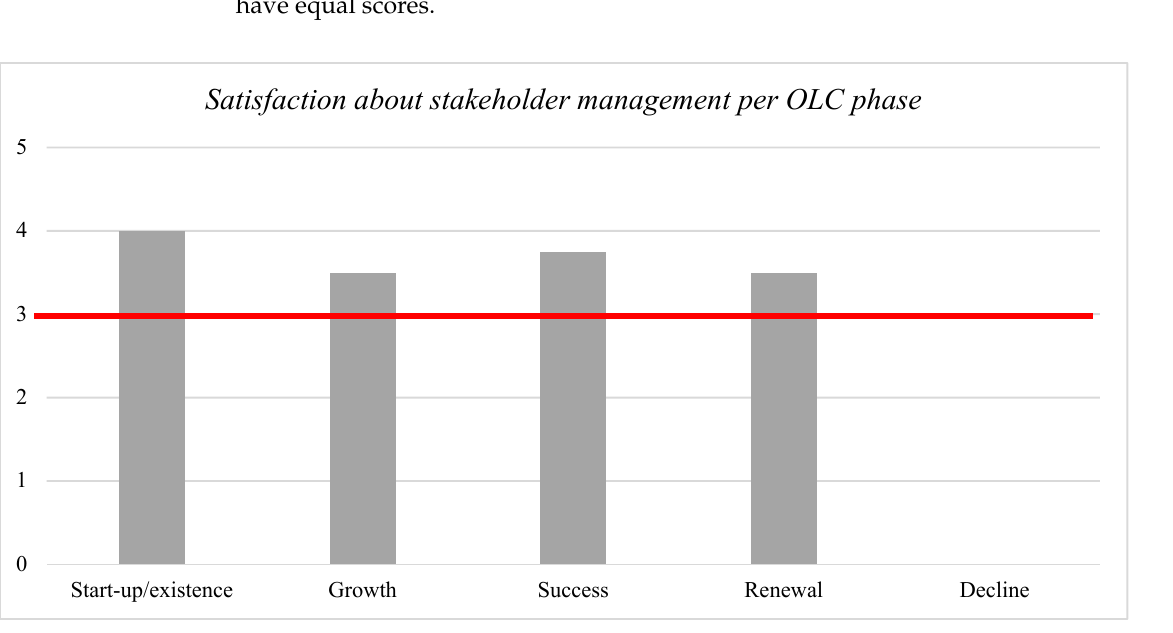
Figure 11. Stakeholder management satisfaction scores from the USO’s respondents per OLC stage.